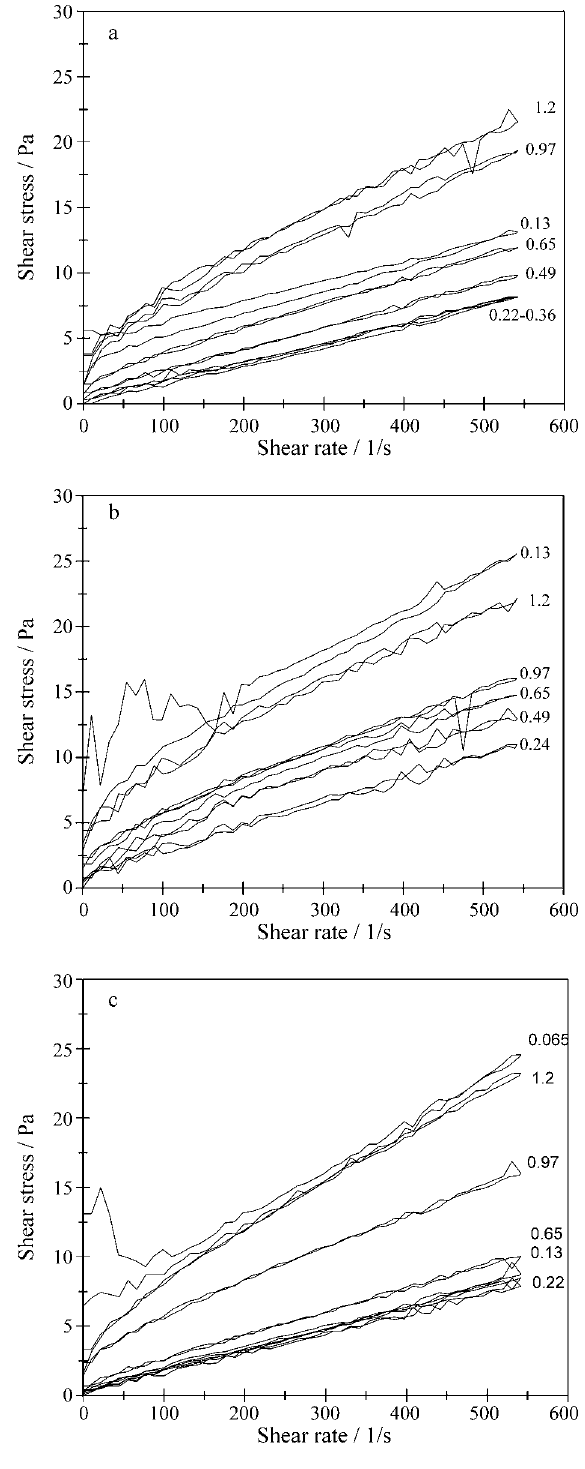
Figure 2. Shear stress vs. shear rate curves for alumina-zircon suspensions (48 vol%) with different content (wt/wt %) of dispersant. a : stoichiomet- ric, b : with a 6 wt% excess of alumina, c: with a 10 wt% excess of zircon powder